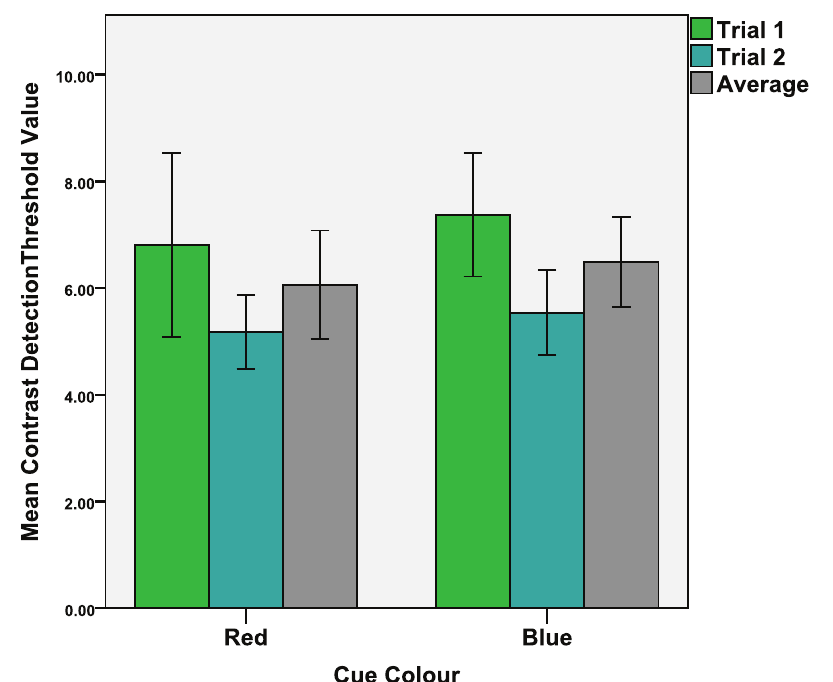
Figure 2. Mean detection threshold values for the contrast (local) task. Mean values of the 1st and 2nd trials as well as the average value of both trials. Error bars indicate the 95% confidence interval.